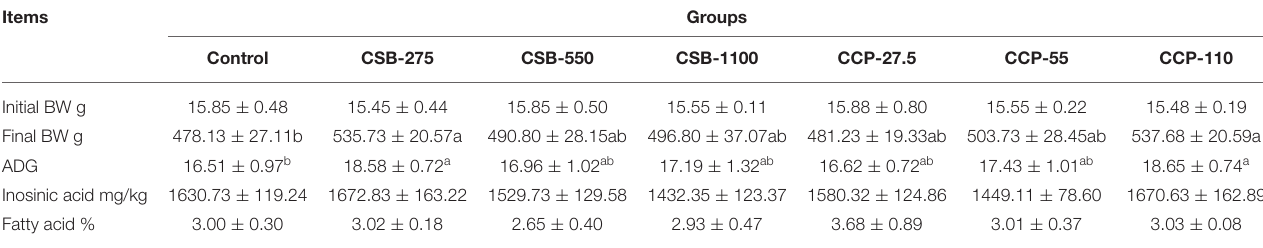
TABLE 2 | Effects of coated sodium butyrate (CSB) and polysaccharides from Cordyceps cicadae (CCP) on growth performance and meat quality of squabs.